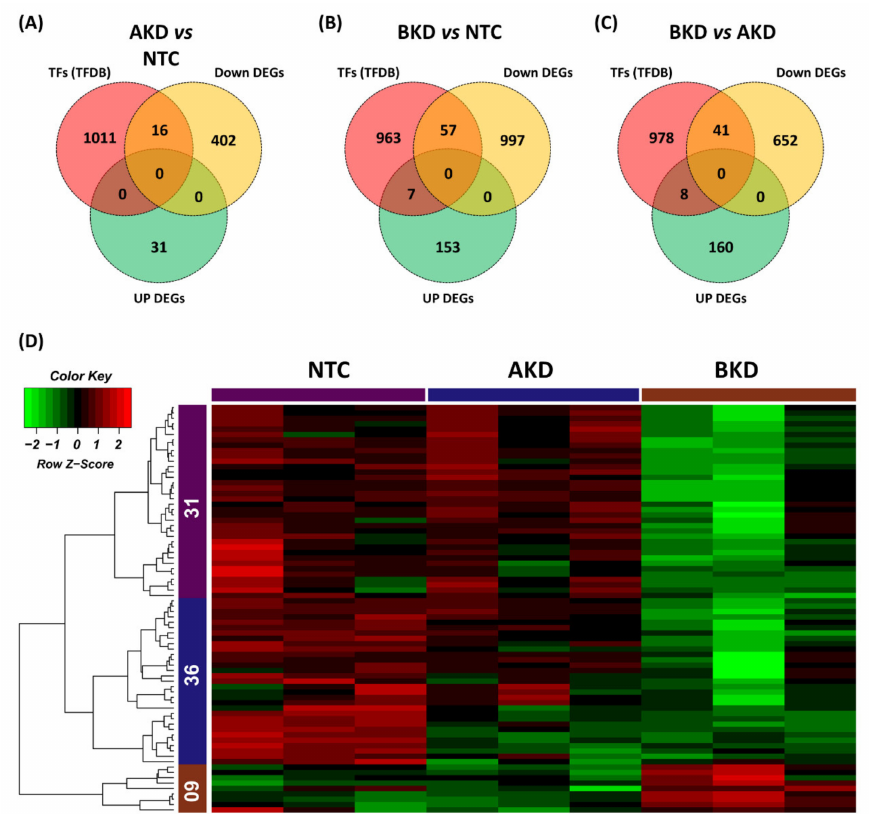
Figure 10. Venn plots to identify differentially expressed transcription factors (TFs) in ( A ) AKD vs. NTC, ( B ) BKD vs. NTC, and ( C ) BKD vs. AKD. ( D ) Heatmap of all differentially expressed TFs. A total of 76 transcription factors were distributed in 3 clusters based on their co-expression with cut-off criteria of FPKM > 5, |logFC > 2|. In the color key, the red color represents upregulation, the green color represents downregulation, and the black color represents no change in